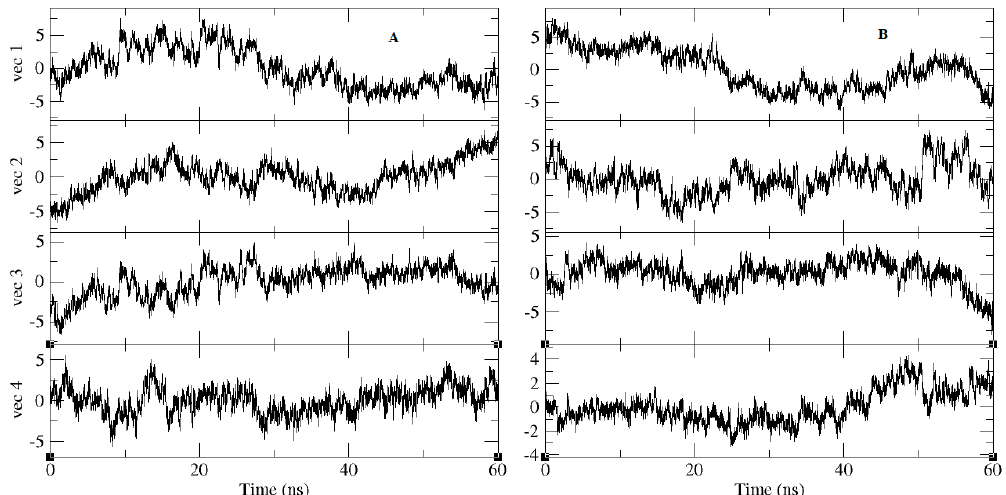
Figure 8. Principal-component analysis of trajectories of both complexes ( A ) NuBBE-1970–NSP15 and ( B ) NuBBE-242–NSP15. Projections of all four eigenvectors during simulation. Calculation was considered for total of 60 ns of simulation.